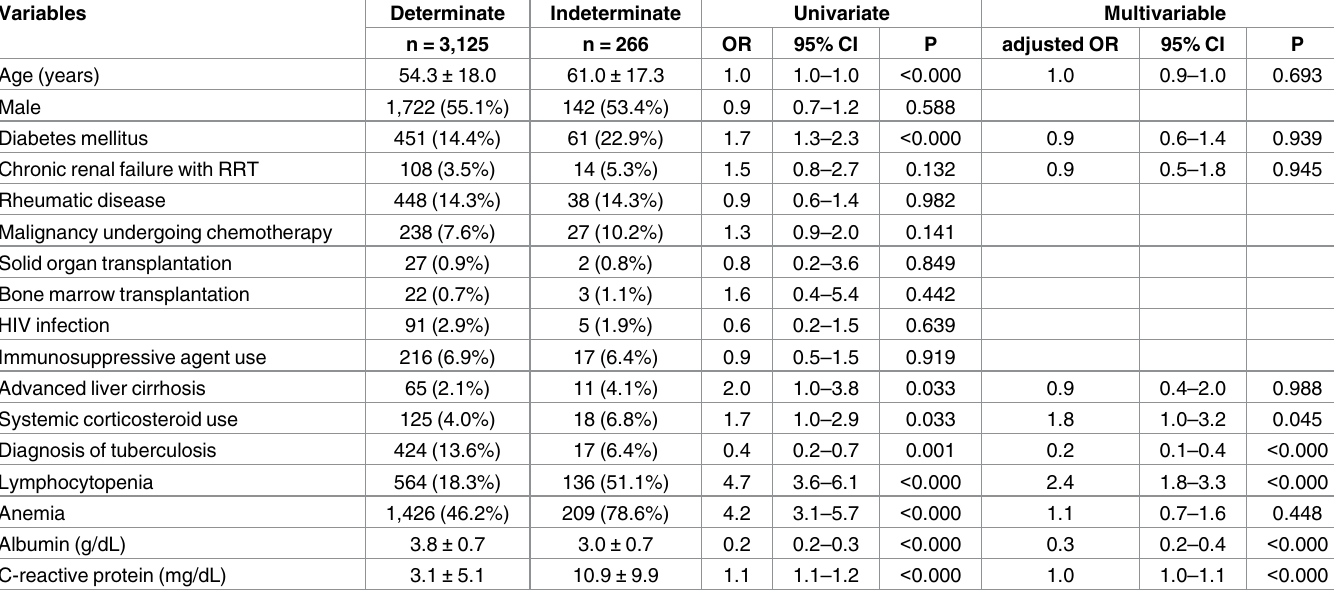
Table 2. Comparison between the determinate and indeterminate QFT-GIT result groups using logistic regression analysis.